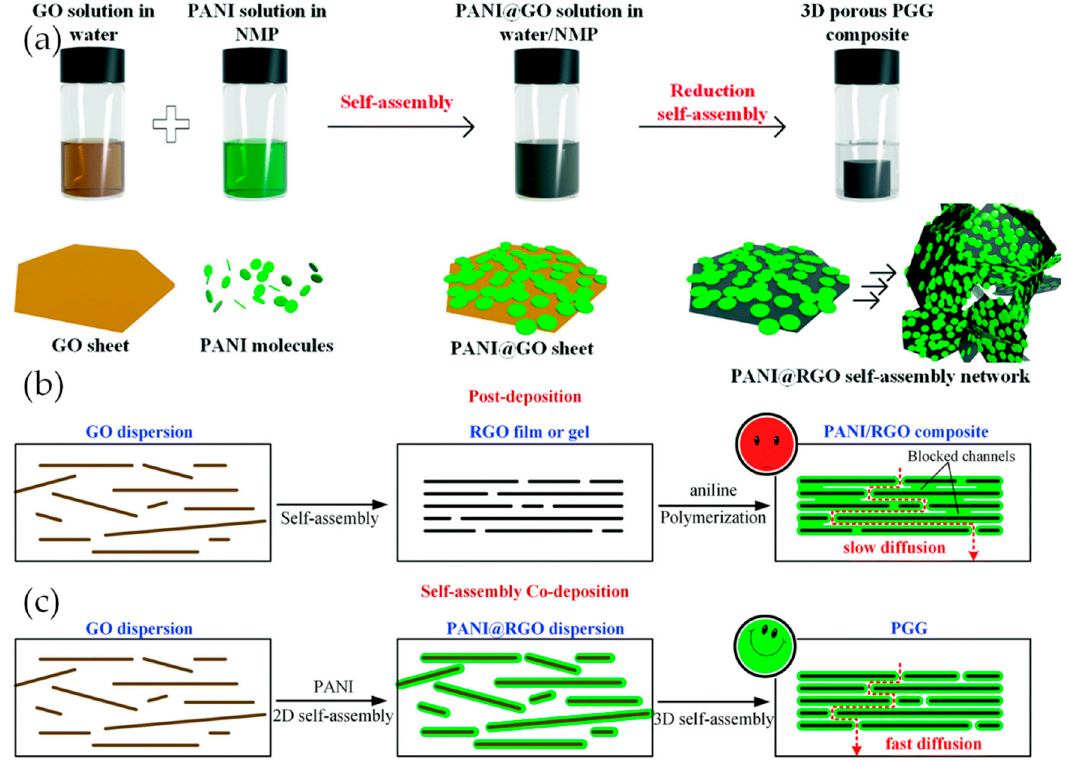
Figure 2. ( a ) Schematic illustration of the solution-based self-assembly method for the preparation of PGGs; ( b ) Schematic illustration of the formation of partially blocked channels in in situ polymerization of aniline on an RGO matrix; ( c ) Schematic illustration of the formation of unblocked channels in a self-assembly process. Reproduced with permission from [48]. The Royal Society of Chemistry (2018).